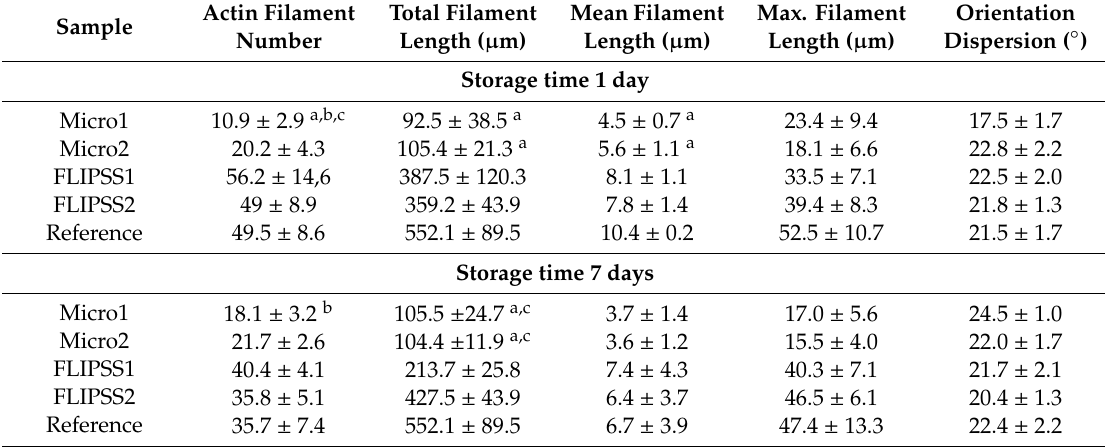
Table 4. Quantitative analysis of the actin cytoskeleton organization was performed using the FilaQuant software (confocal images in Figure 3); *(mean ± s.e.m.; ANOVA post hoc Bonferroni, n = 10 cells; n.s. between 1 day vs 7 days laser